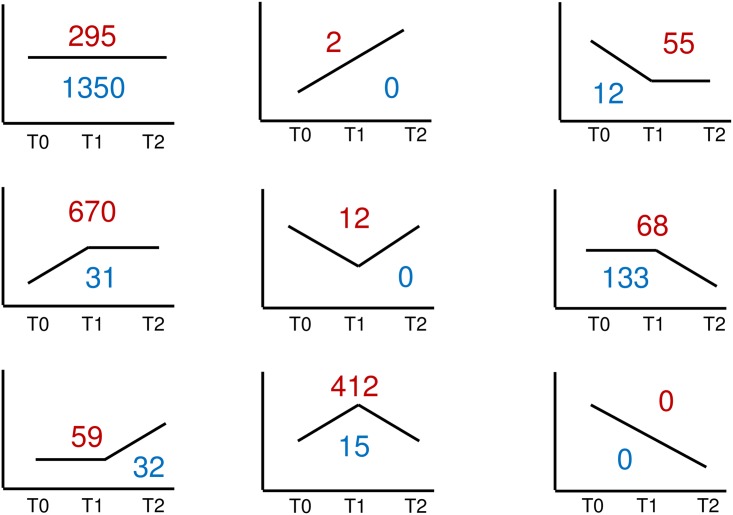
Cluster analysis of gene expression asthmatics (red) and controls (blue).A total of 1573 genes had at least 1.5 fold change in controls or asthmatics with significant dysregulation (p adj < 0.05). 1350 of these genes were unchanged in controls. 295 of these genes were unchanged in asthmatics. 670 genes were upregulated from T0 to T1 and unchanged from T1 to T2 in asthmatics. 412 genes were upregulated from T0 to T1 and downregulated from T1 to T2 in asthmatics.